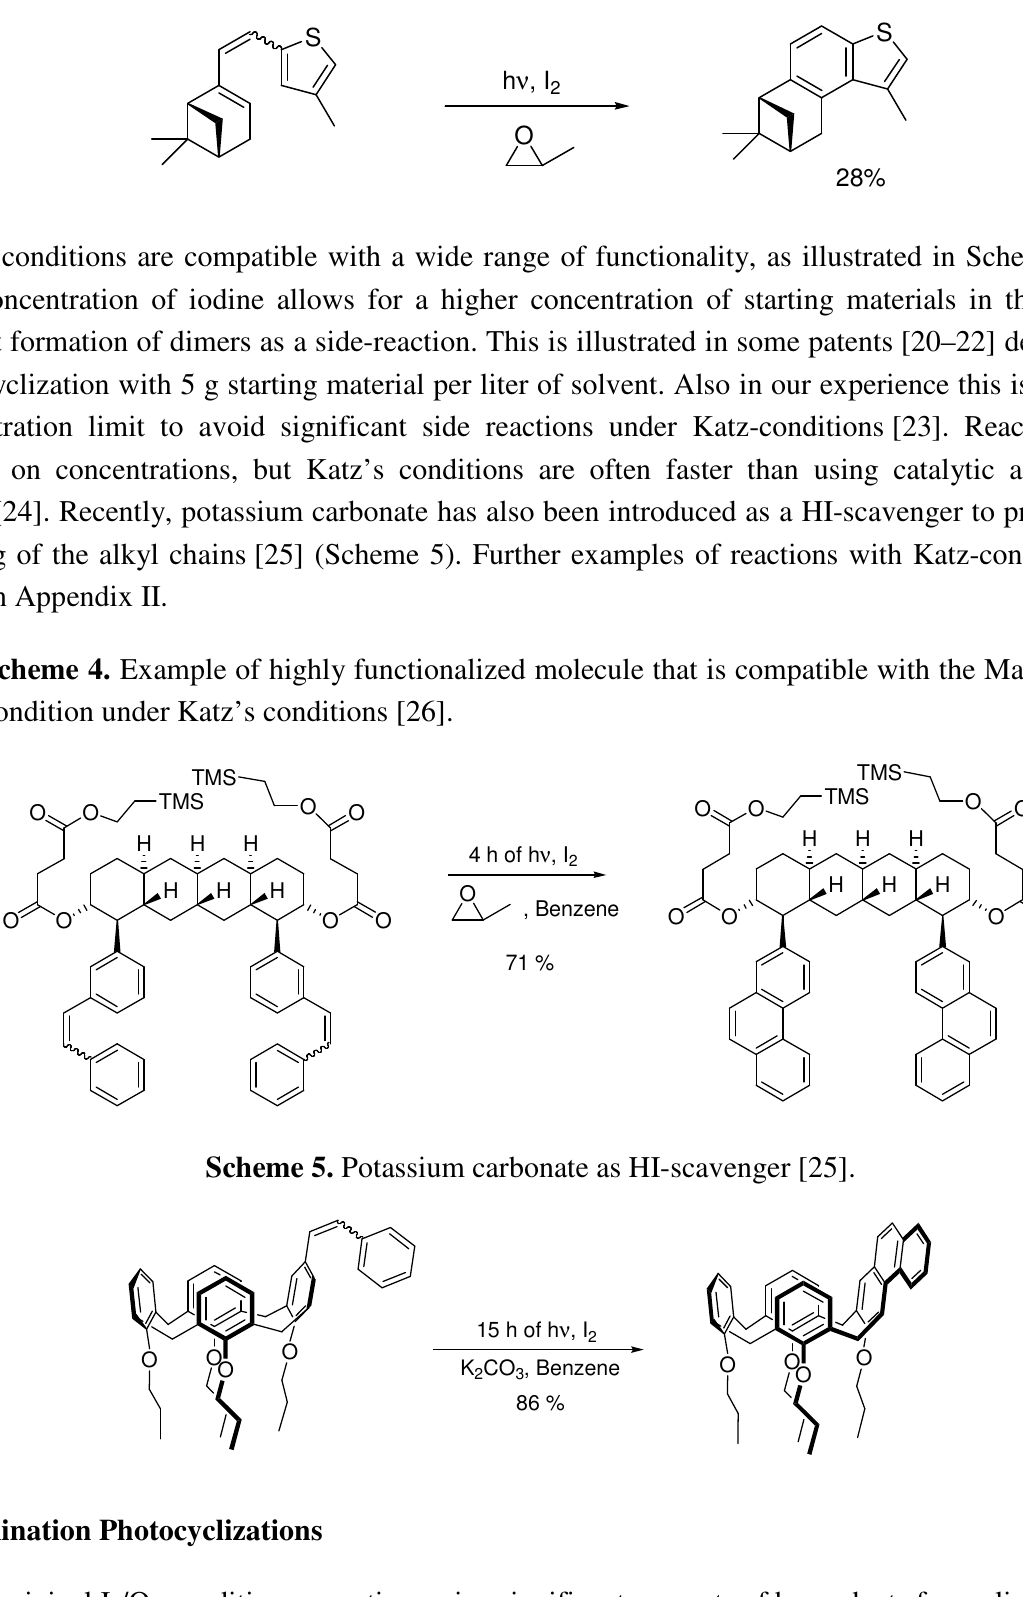
Scheme 3 . Photochemical cyclization of a less reactive